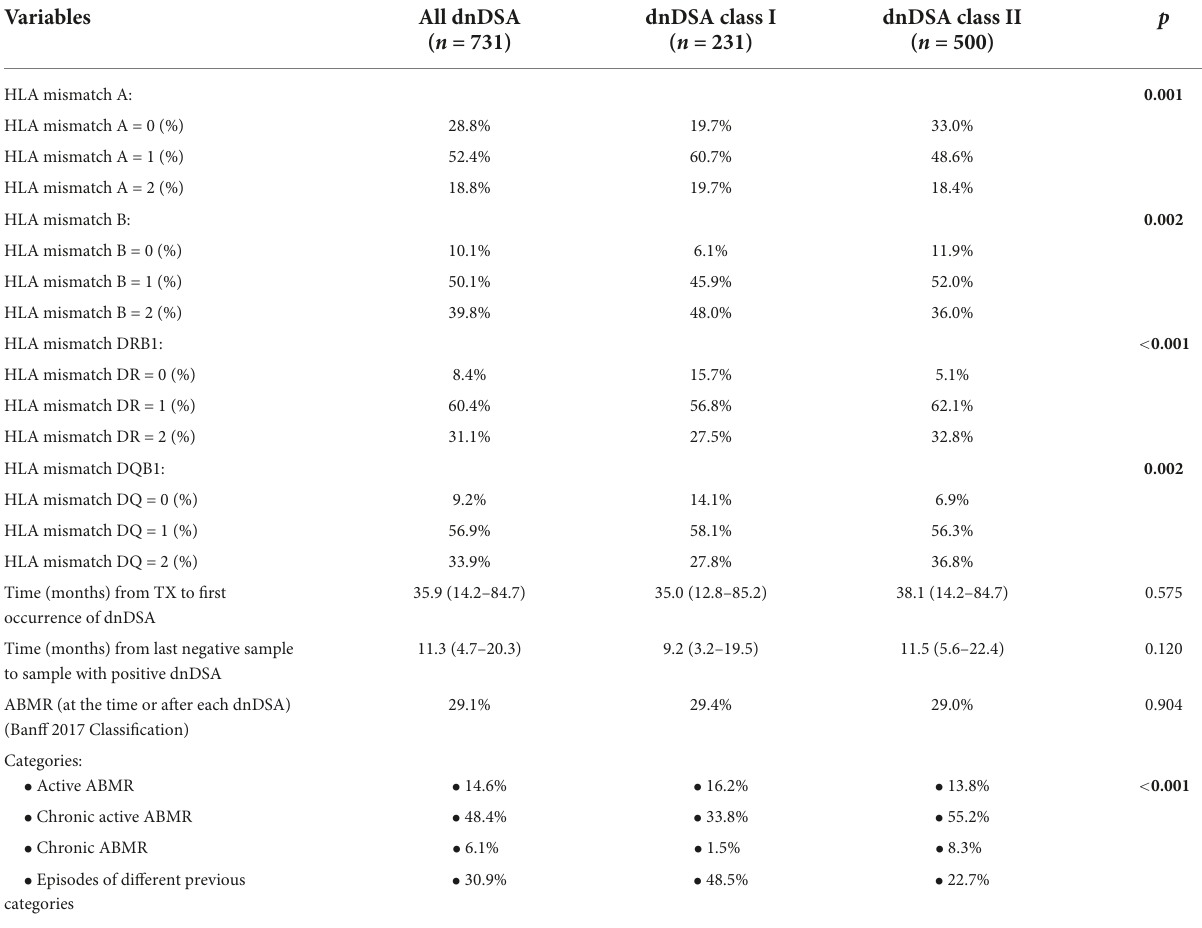
TABLE 2 Characteristics of